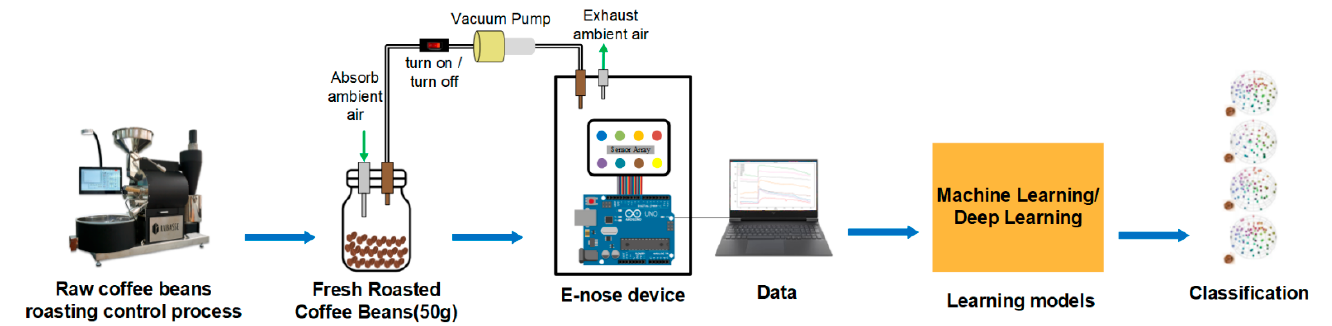
Figure 1. System framework.